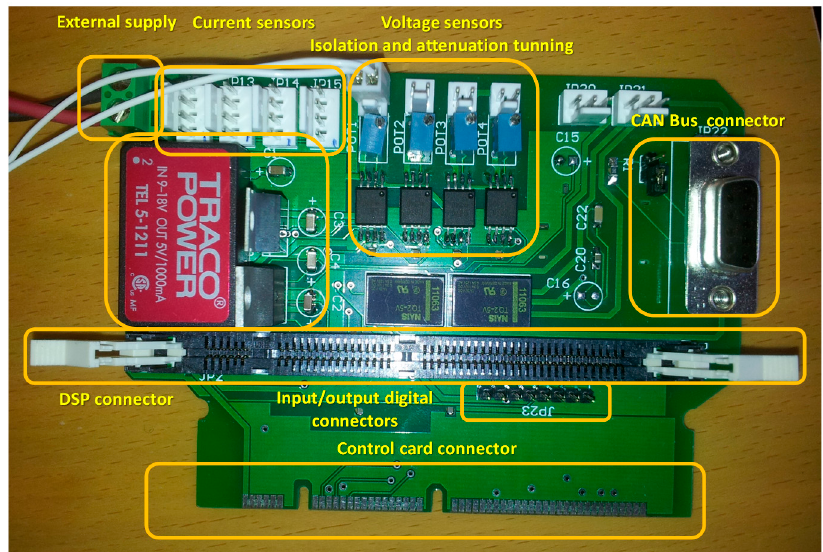
Figure 25. Control card. Figure 25. Control